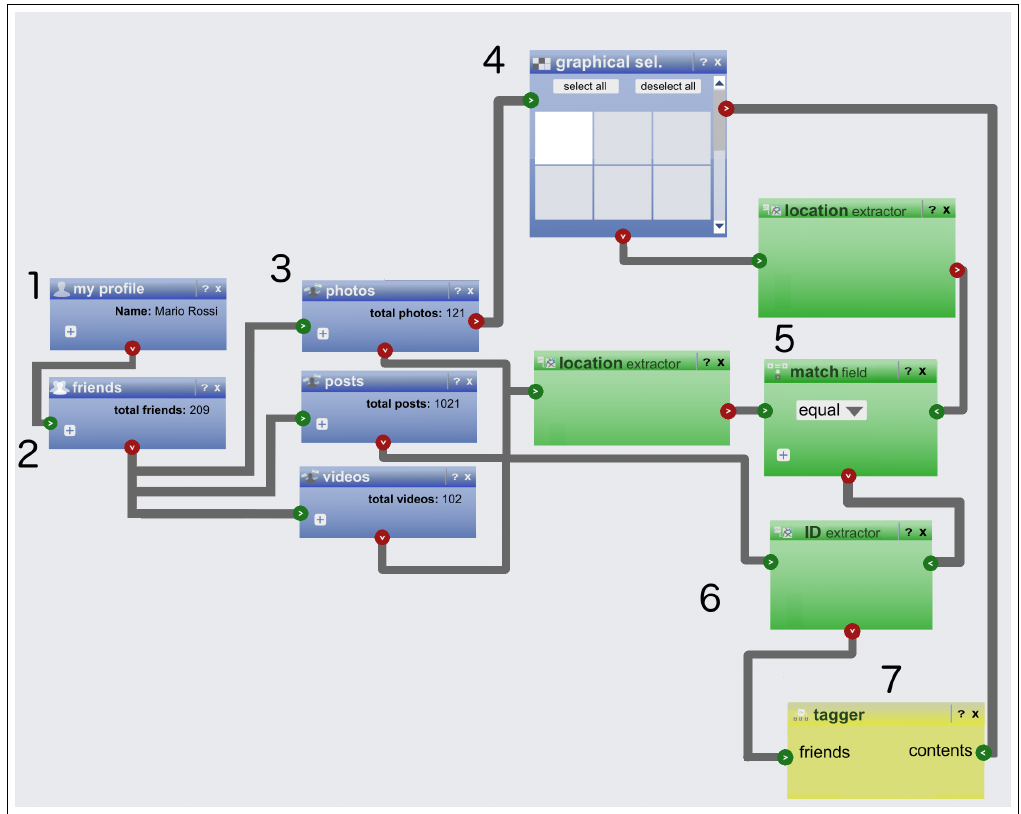
Figure 1. A mock-up of the social network application (SNA) solving the scenario problem with the first FaceMashup design, which used a pipe paradigm for connecting data (blue boxes), filters (green boxes) and actions (yellow